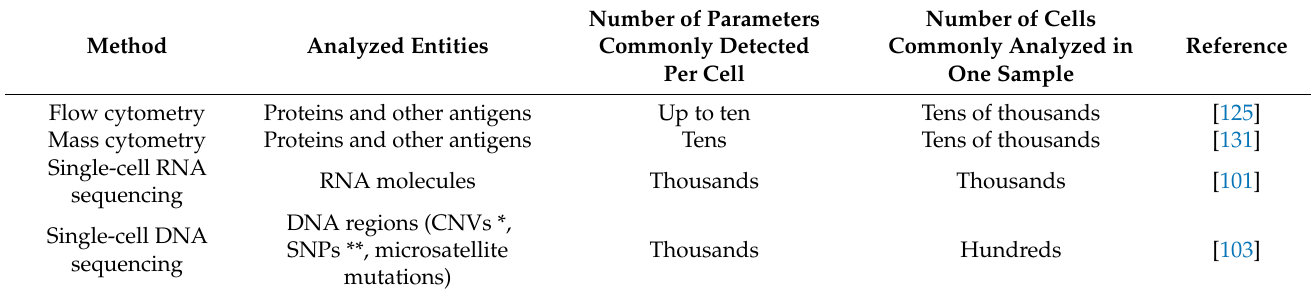
Table 3. The capacities of current high-throughput single-cell